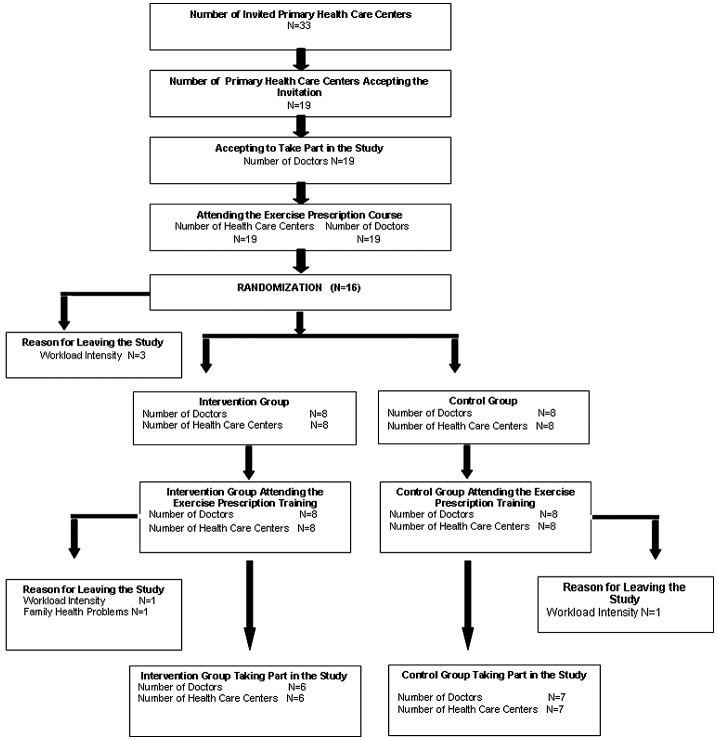
Consort diagram.